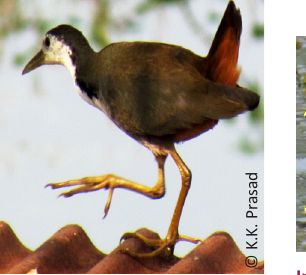
Image 23. Common Moorhen Gallinula chloropus